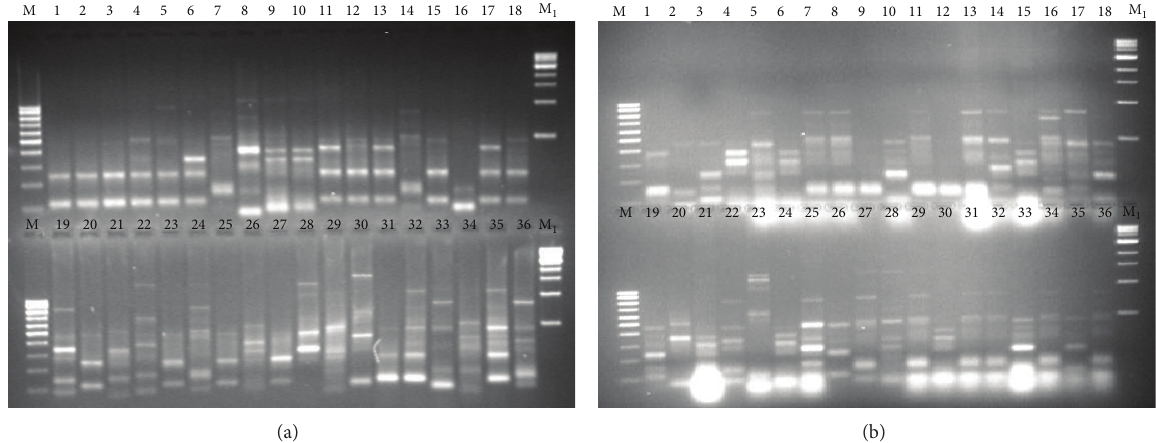
Figure 1: Electrophoretic patterns of interdelta region obtained from seventy-two Saccharomyces cerevisiae randomly isolated at the end of spontaneous fermentation of Susumaniello grapes. Panel (a): lines 1 to 36 correspond to strains from S1 to S36. Panel (b): lines 1 to 36 correspond to strains from S37 to S72. M, 100 bp DNA Ladder (New England Biolabs, USA); M 1 , 1Kb DNA Ladder (New England Biolabs, USA).